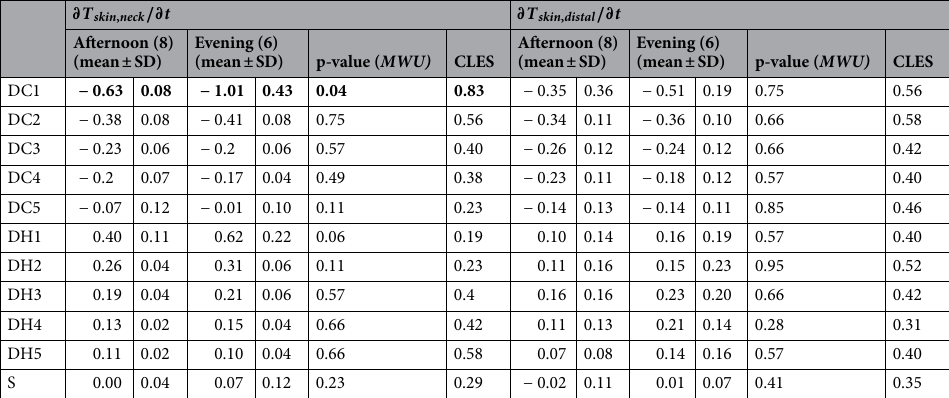
Table 4. Time-of-day differences in the rate of change of the neck and distal skin temperature over the course of the last two partial-body cooling and warming transients. Significant values are in